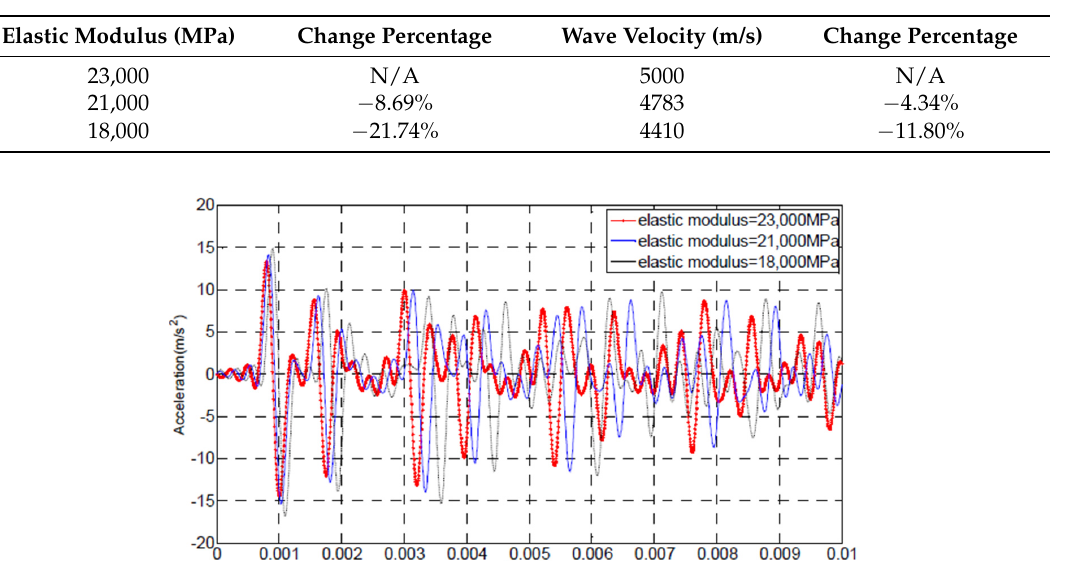
Table 5. Study on elastic modulus for orthotropic material model (longitudinal direction).